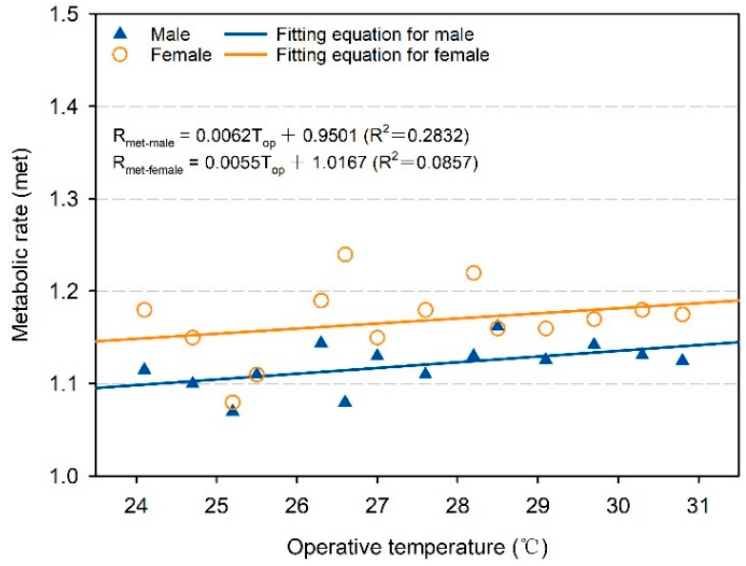
Figure 12. The relationship between operative temperature and metabolic rate.